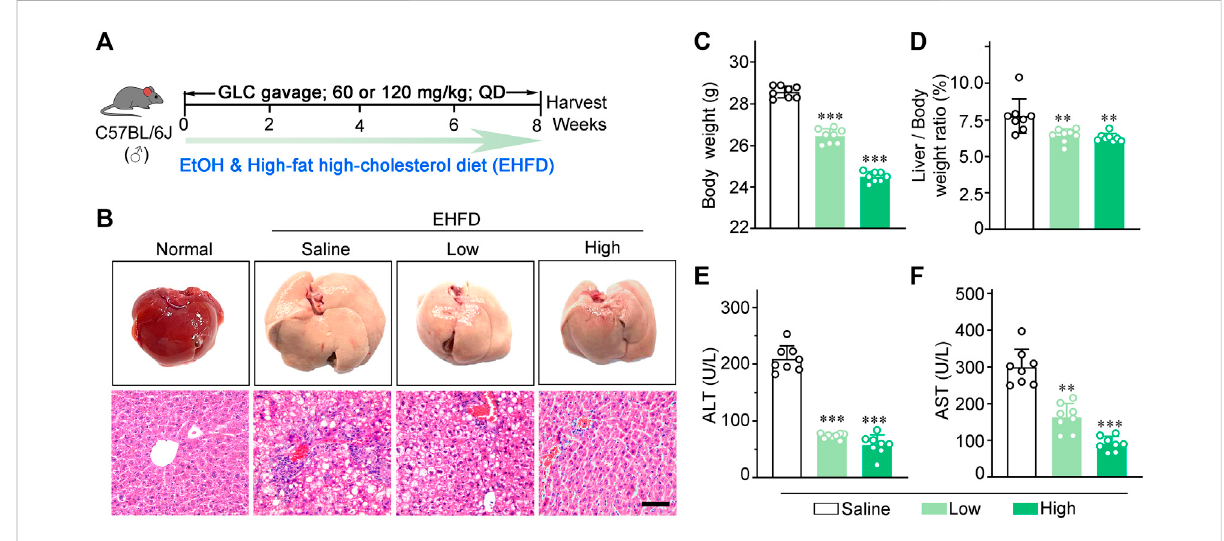
FIGURE 1 GLC alleviates steatohepatitis induced by EHFD diet. (A) Schematic of the liver injury mouse model induced by EHFD diet. (B) Representative images of the mouse liver and H&E staining with EHFD treatment. Scale bars, 50 μ m. (C) The fi nal body weight and (D) liver index of EHFD mice (n = 8 for each group). (E) Serum ALT and (F) AST levels of EHFD mice with or without GLC treatment ** P < 0.01 vs. the EHFD mice with the treatment of saline; *** P < 0.001 vs. the EHFD mice with the treatment of